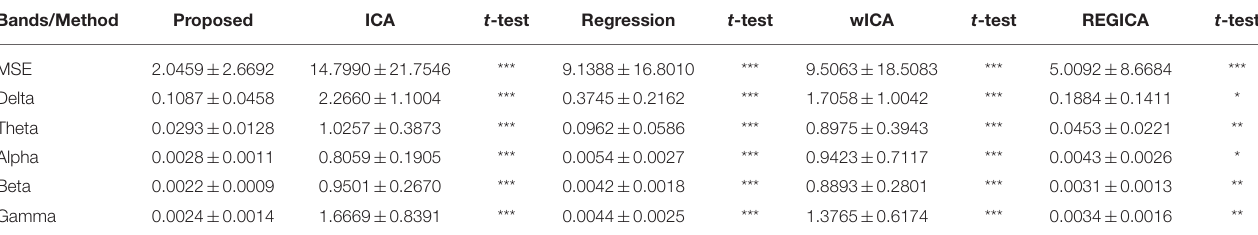
TABLE 3 | Average mean square error and mean absolute error values results in different frequency bands for the proposed method against conventional methods using simulated EEG datasets. Bands/Method